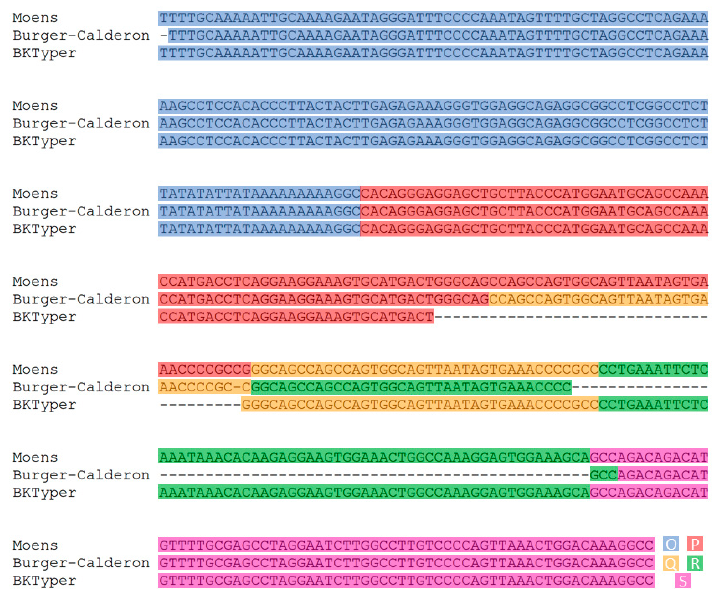
Figure 2. Visual inspection of the NCCR sequence alignment between Moens et al.,